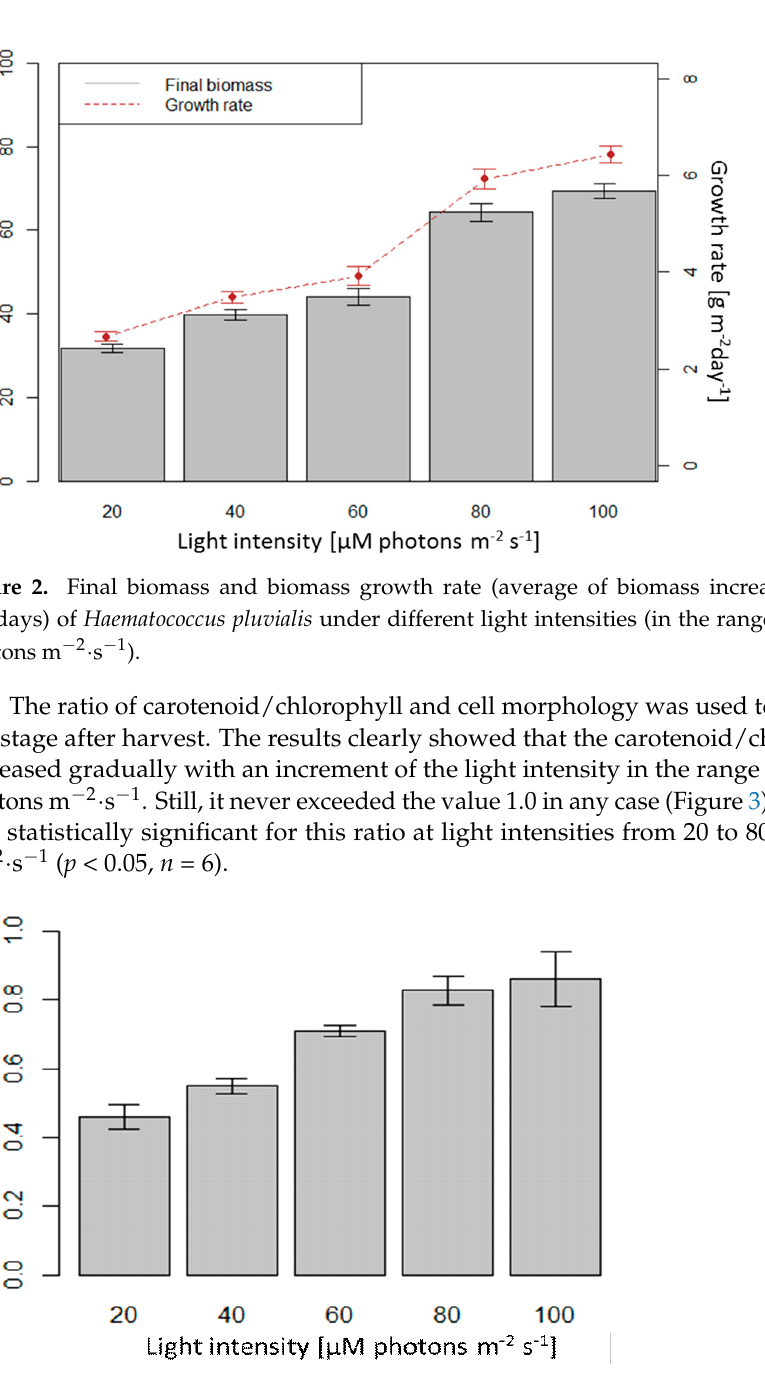
Figure 3. The ratio of carotenoids to chlorophylls in H. pluvialis under different light intensities (in the range of 20–100 µmol photons m − 2 ·s − 1 ).